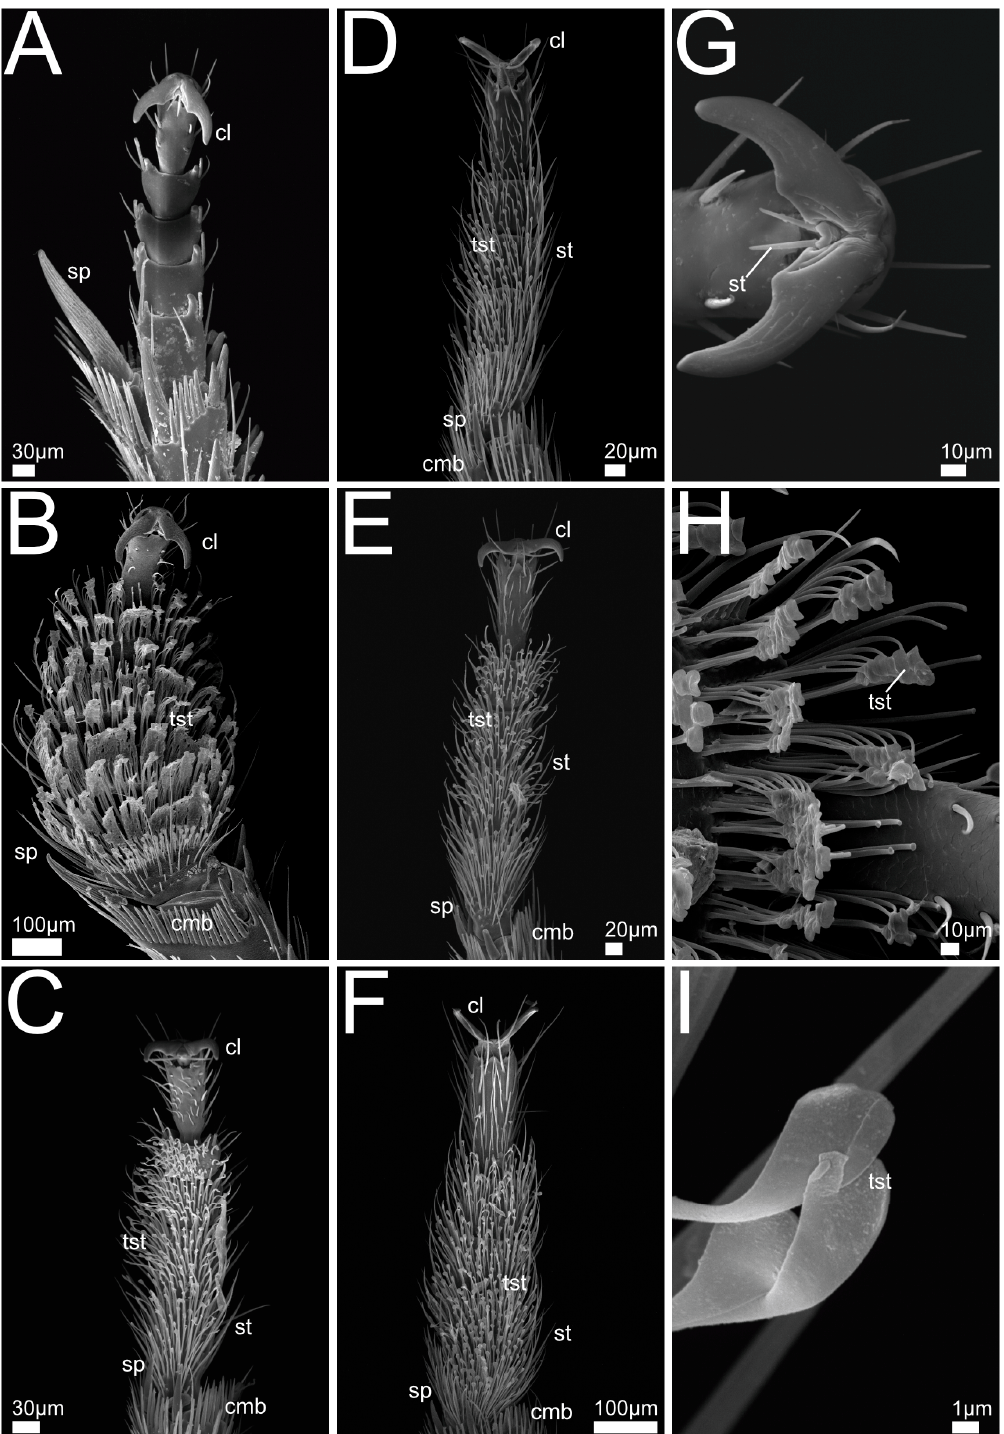
Figure 5. SEM views of Xantholinini, Othiini and Stilicina front legs. Images A – F with ventral view of claw, tarsomeres and end of tibia (left front leg). G – I , detailed views of adhesive setae and claw, ( A ) Gyrohypnus fracticornis (male); ( B ) Othius punctulatus (male); ( C ) Rugilus erichsonii (male); ( D ) R. mixtus (male); ( E ) R. orbiculatus (male); ( F ) R. rufipes (male); ( G ) G. fracticornis (male), ventral view of claw (left front leg); ( H ) O. punctulatus (male), ventral view of fourth and fifth tarsomere; ( I ): R. orbiculatus (male), ventral view of adhesive spatulate seta heads. Abbreviations: cl: claw; cmb: comb-like structure; sp: spur; st: setae (non-adhesive); tst: tenent setae.